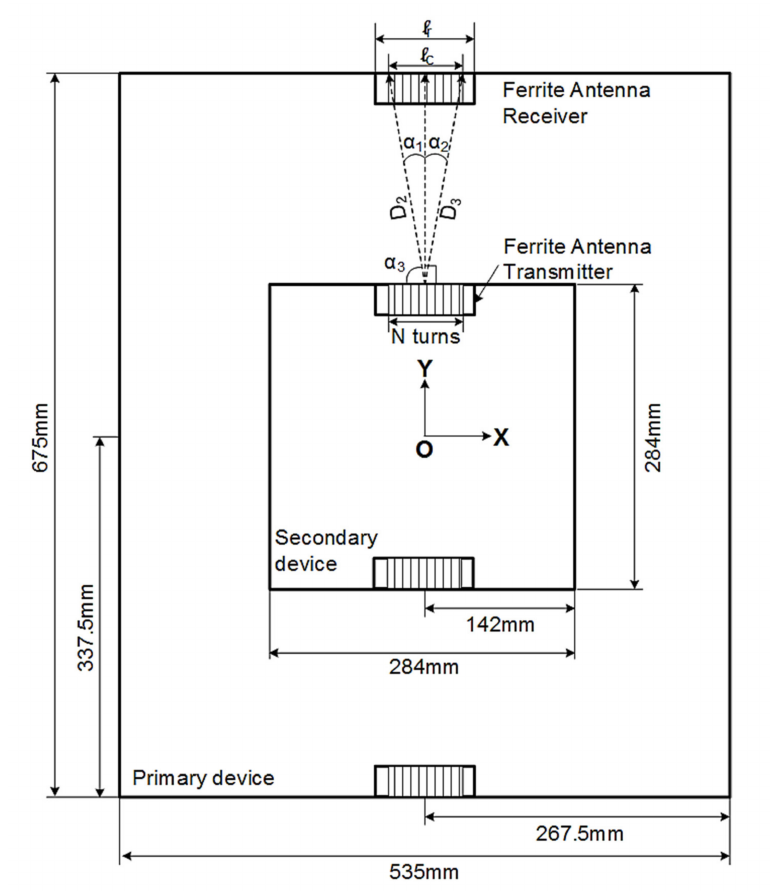
Figure 14. XY-plane view of the ferrite antenna transmitter in the ± y-direction mounted on the secondary device and the ferrite antenna receiver in the ± y-direction mounted on the primary